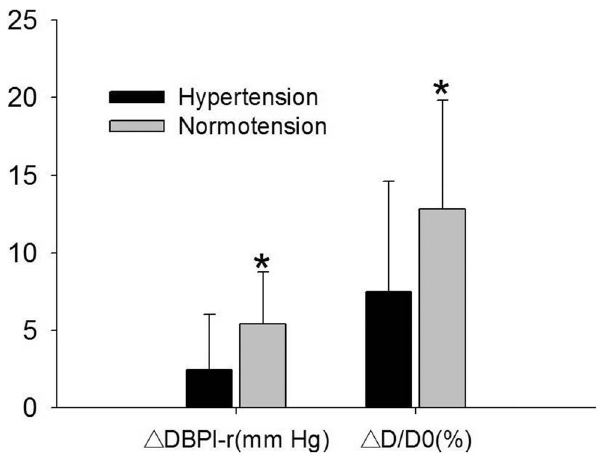
Figure 3. Comparison of D D/D0 and D DBPl-r between groups with hypertension or normotension. * P , 0.001 compared with hypertension group. D D/D0: percentage increase in right brachial artery diameter. D DBPl-r: DBPl-r change following ischemia. (DBPl-r: DBP difference between left and right arms).